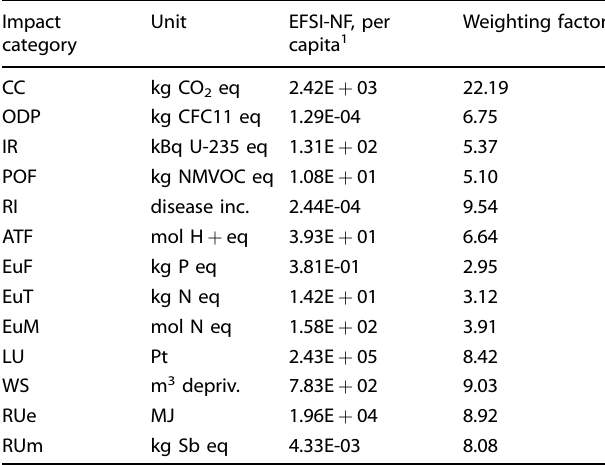
Fig. 1 Environmental impact characterization including the 13 impact categories of the ILCD methodology of the representative food items of the European Food Basket. Where CC is climate change; ODP is ozone depletion potential; IR is Ionizing radiation; POF is photochemical ozone formation; RI is respiratory inorganics; ATF is acidi fi cation terrestrial and freshwater; EuF is eutrophication freshwater; EuM is eutrophication marine; EuT is eutrophication terrestrial; LU is Land Use; WS is water scarcity; and, RUe is resource use, energy carriers and RUm is resource use, mineral, and Table 1. The European food environmental footprint single index normalization (EFSI-NF) and weighting factors 34 .